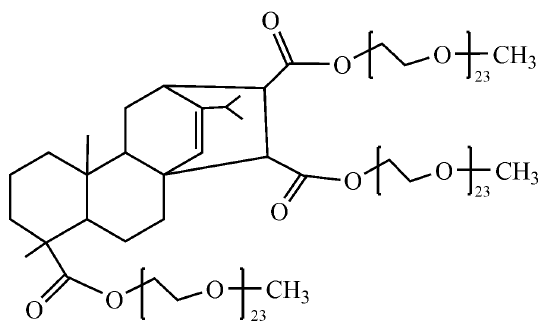
Figure 1. Schematic illustration of mPEG-maleic rosin copolymer.